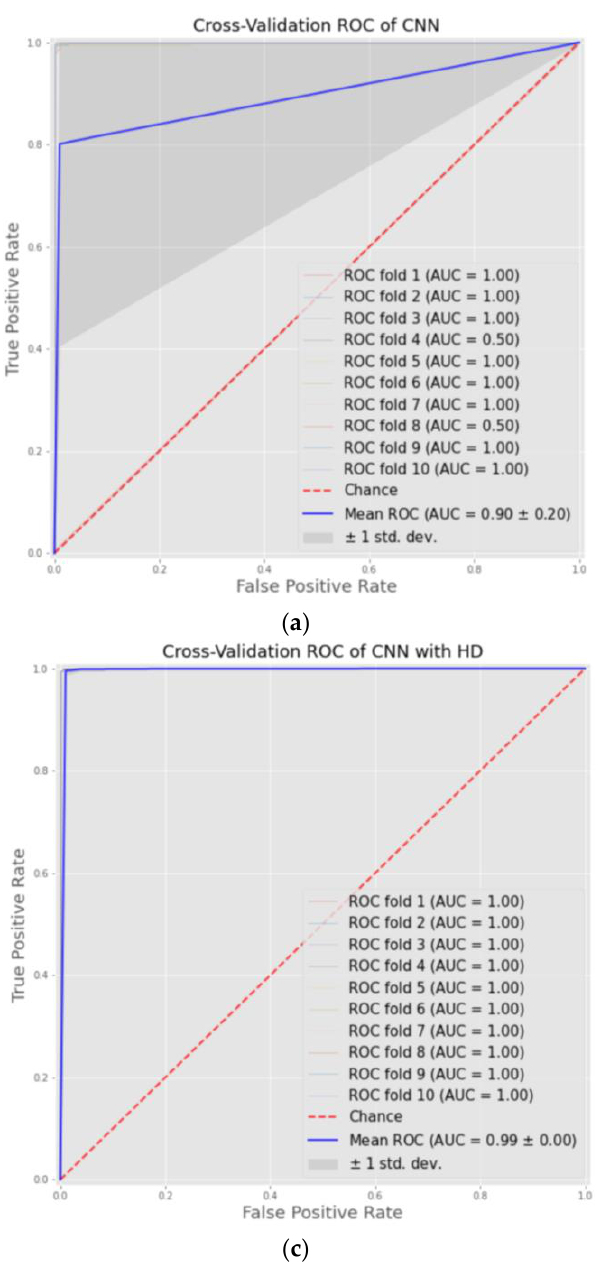
Figure 2. ROC curves of cross-validation results of four models as: ( a ) CNN model; ( b ) CNN-SL model; ( c ) CNN-HD model; ( d ) CNN-SF model.